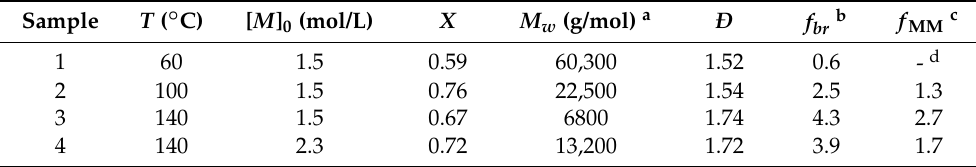
Table 1. Summary of reactions conducted and properties of synthesized polymers.